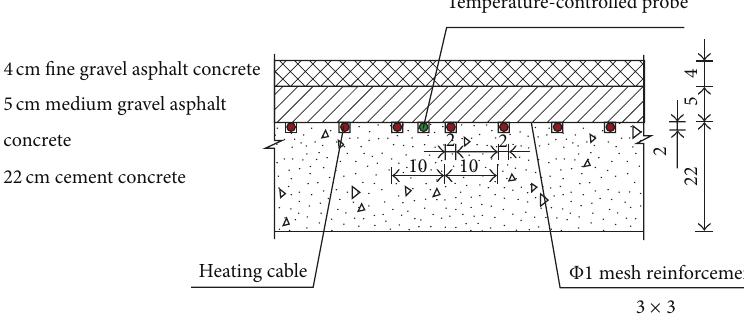
Figure 6: Schematic diagram of the pavement with electric heat tracing system.